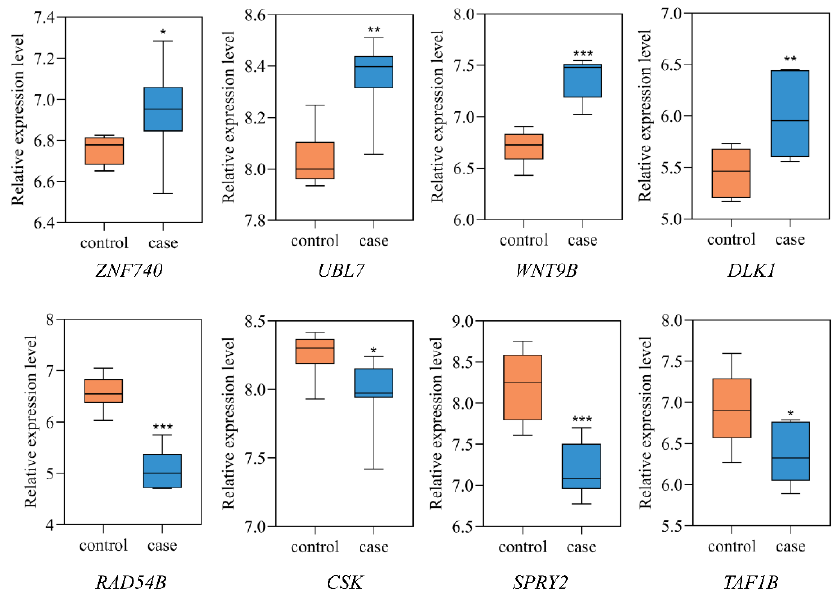
Figure 4. Eight differentially expressed genes between NSCL/P and healthy controls. The expression levels of differentially expressed genes in dental pulp stem cells (GSE42589) or orbicularis oris muscles (GSE85748) were compared between NSCL/P patients and healthy controls. * p < 0.05, ** p < 0.01, *** p <